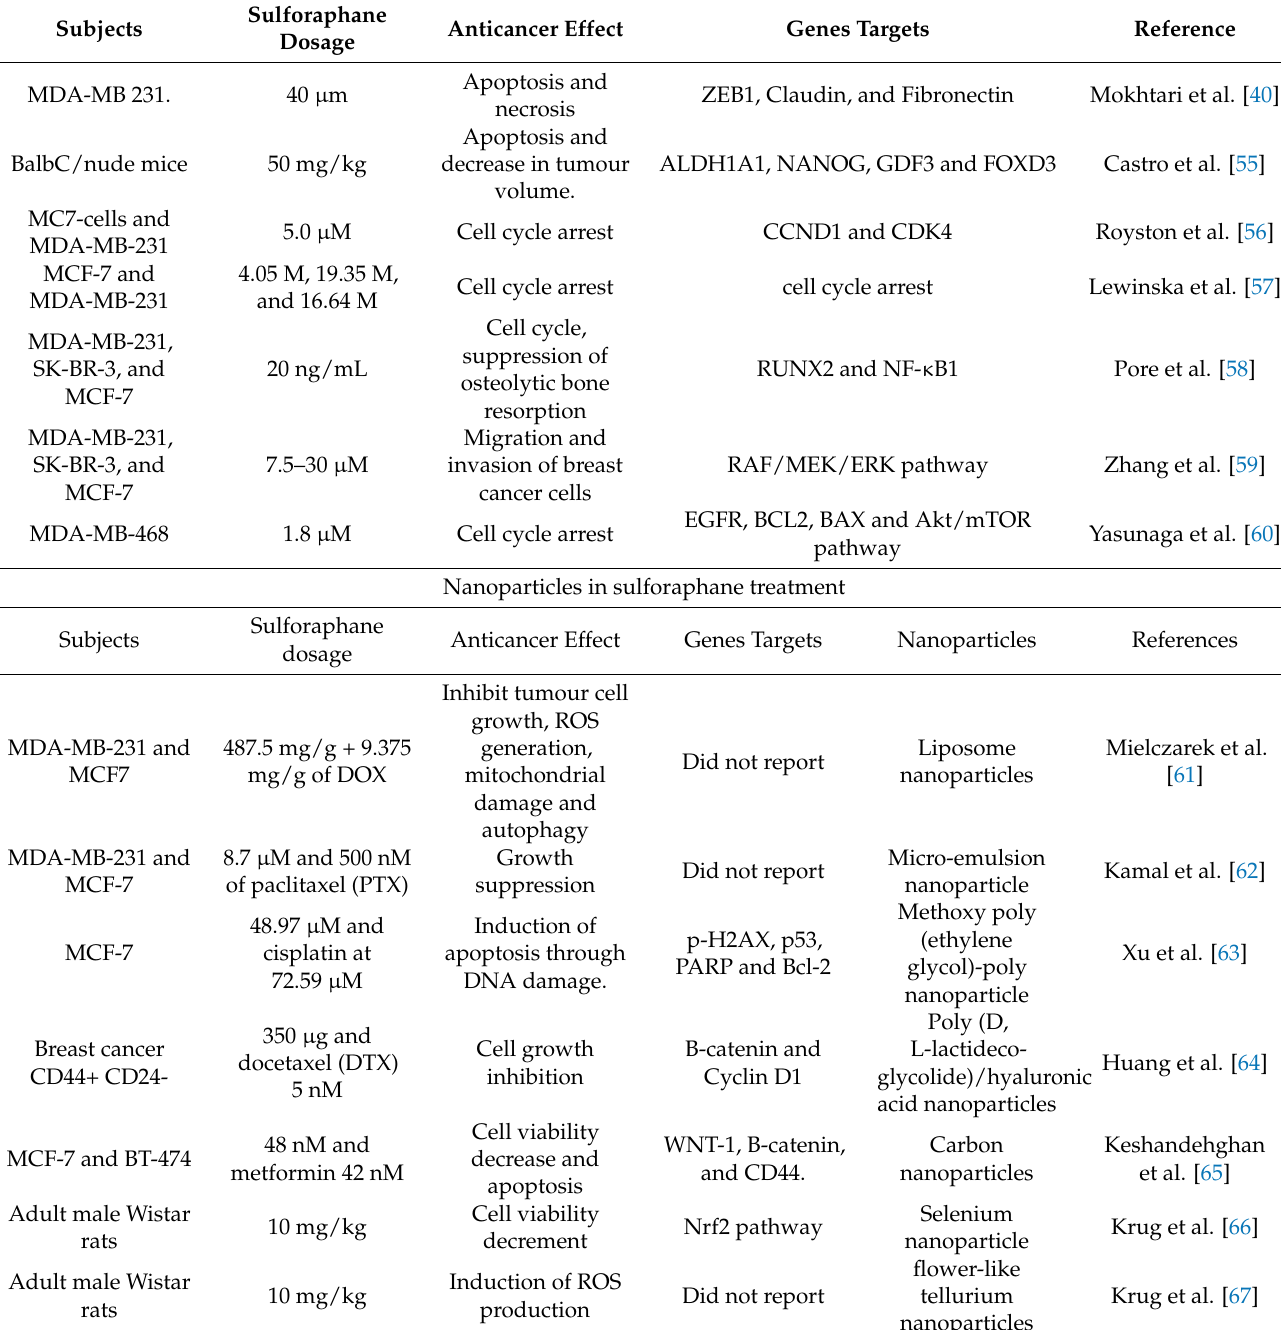
Table 2. Sulforaphane effect in breast